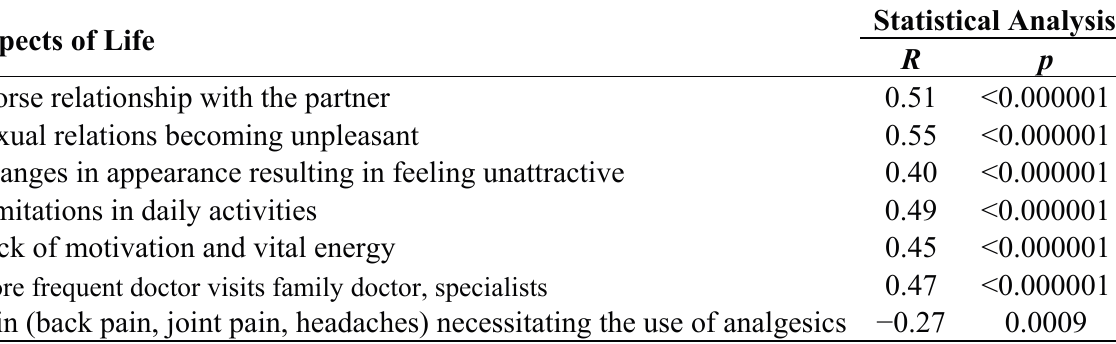
Table 7. Correlations between QoL and the strength of climacteric symptoms’ influence on various aspects of